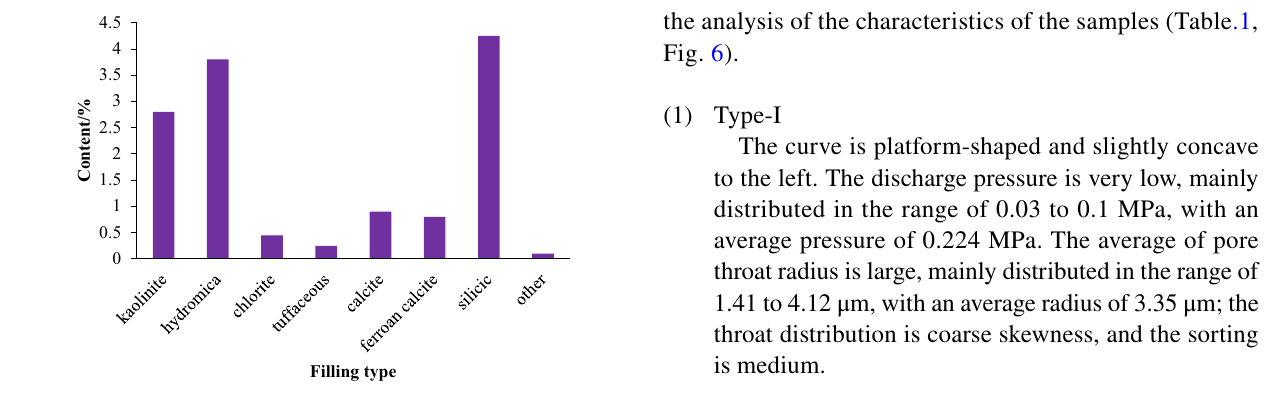
pores in grains, 2599.45 m; E: intercrystalline pore of kaolinite, 2629.63 m; F: microfracture, 2443.45 m)